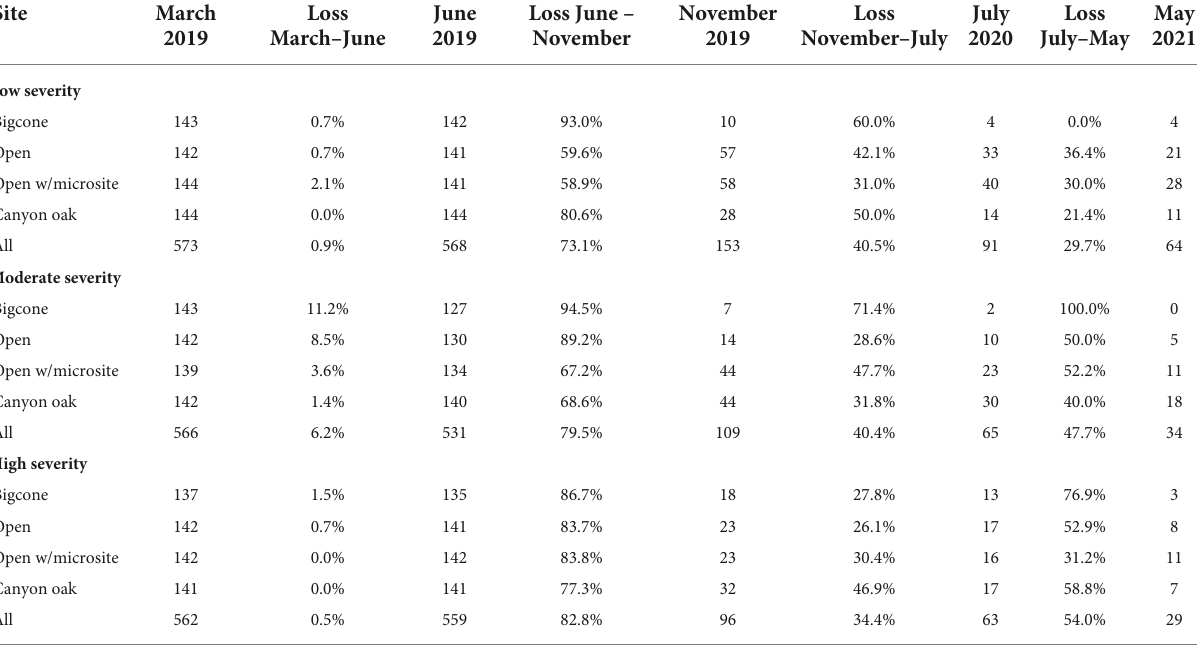
TABLE 1 Number of surviving seedlings throughout the